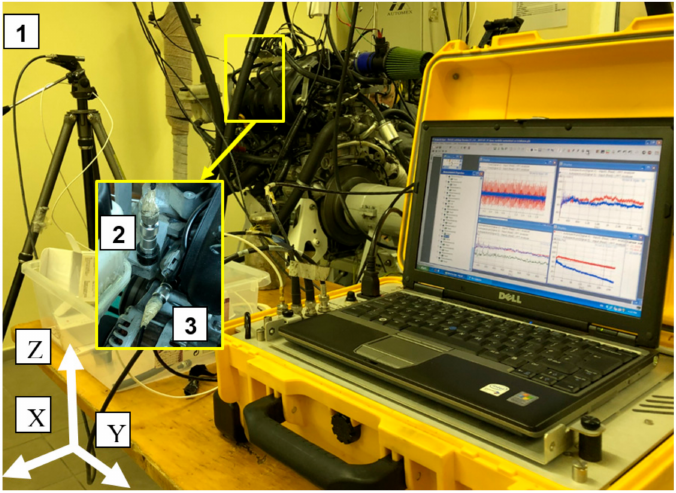
Figure 2. Sound pressure and vibration measuring equipment layout. 1—Gras 46AE free-field micro- phone; 2—accelerometer for transverse direction measurements; 3—accelerometer for longitudinal direction